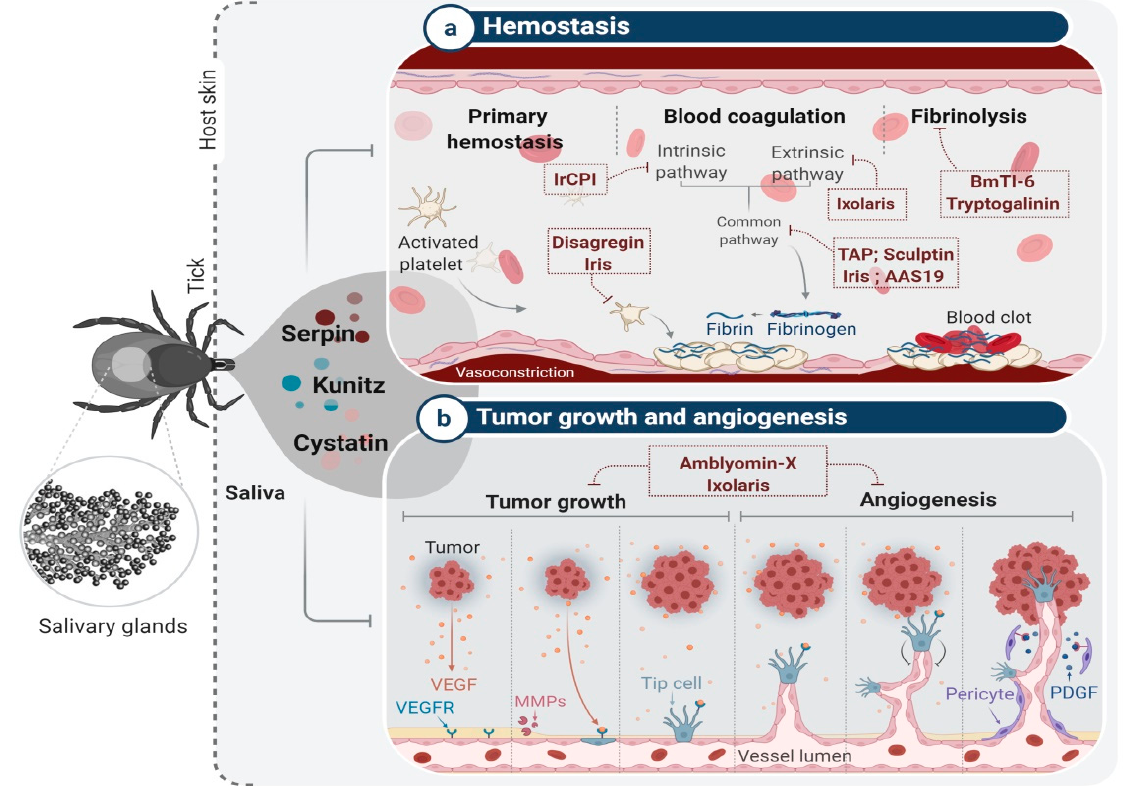
Figure 3. Examples of protease inhibitors from tick salivary glands with anti-hemostatic, anti-tumor and anti-angiogenic effects. ( a ) Numerous PIs from tick salivary glands have been characterized as anti-hemostatic compounds targeting platelet aggregation such as Disagregin and Iris, blood coagulation including IrCPI, Ixolaris, TAP, Sculptin, Iris, and AAS19, and fibrinolyses like BmTI-6 and Tryptogalinin. ( b ) With great interest, Amblyomin-X and Ixolaris were found to significantly inhibit tumor growth with efficient anti-angiogenic action.